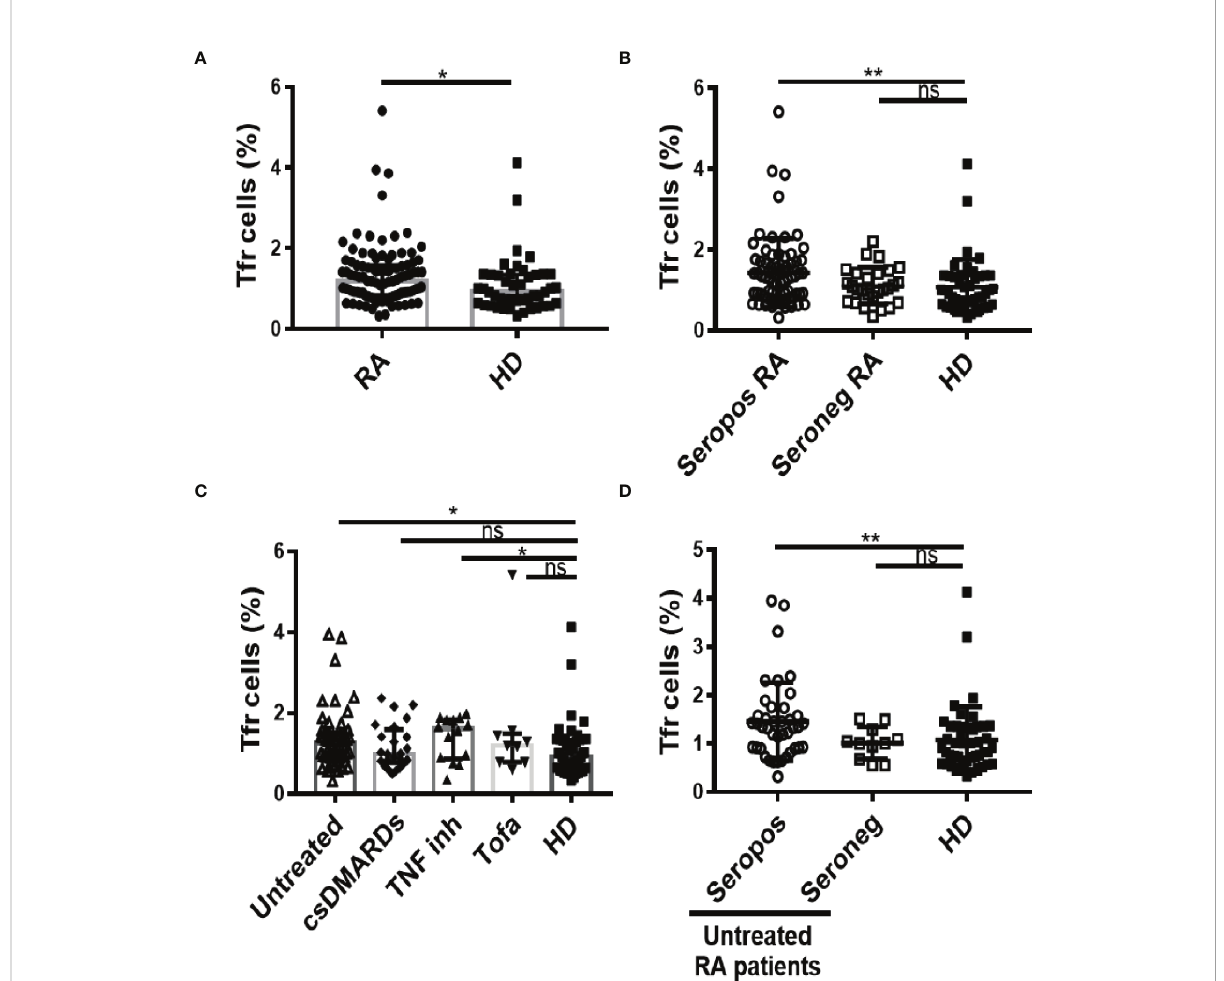
FIGURE 2 Frequency of Tfr cells in RA patients. (A) Frequency of Tfr cells in blood from RA patients (n=99) and HD (n=46). (B) Frequency of Tfr cells in seropositive (Seropos, n=72) and seronegative (Seroneg, n=27) RA patients and HD (n=46). (C) Frequency of Tfr cells in untreated (n=52), RA patients treated with different drugs: csDMARDs (n=24), TNF inhibitor (TNF inh, n=14), tofacitinib (Tofa, n=9) and HD (n=46). (D) Frequency of Tfr cells in Seropos (n=41) and Seroneg (n=11) untreated RA patients and HD (n=46). Symbols represent individual subjects. Mean ± DS is shown in (B) and (D) . Median ± interquartile range is shown in (A) and (C) ; P values were determined by T-Test in (A) . Kruskal-Wallis Test followed by Dunn ’ s Multiple Comparisons Test were determined in (B – D) . Two-tailed probability * p < 0.05, ** p < 0.01, ns, not signi fi